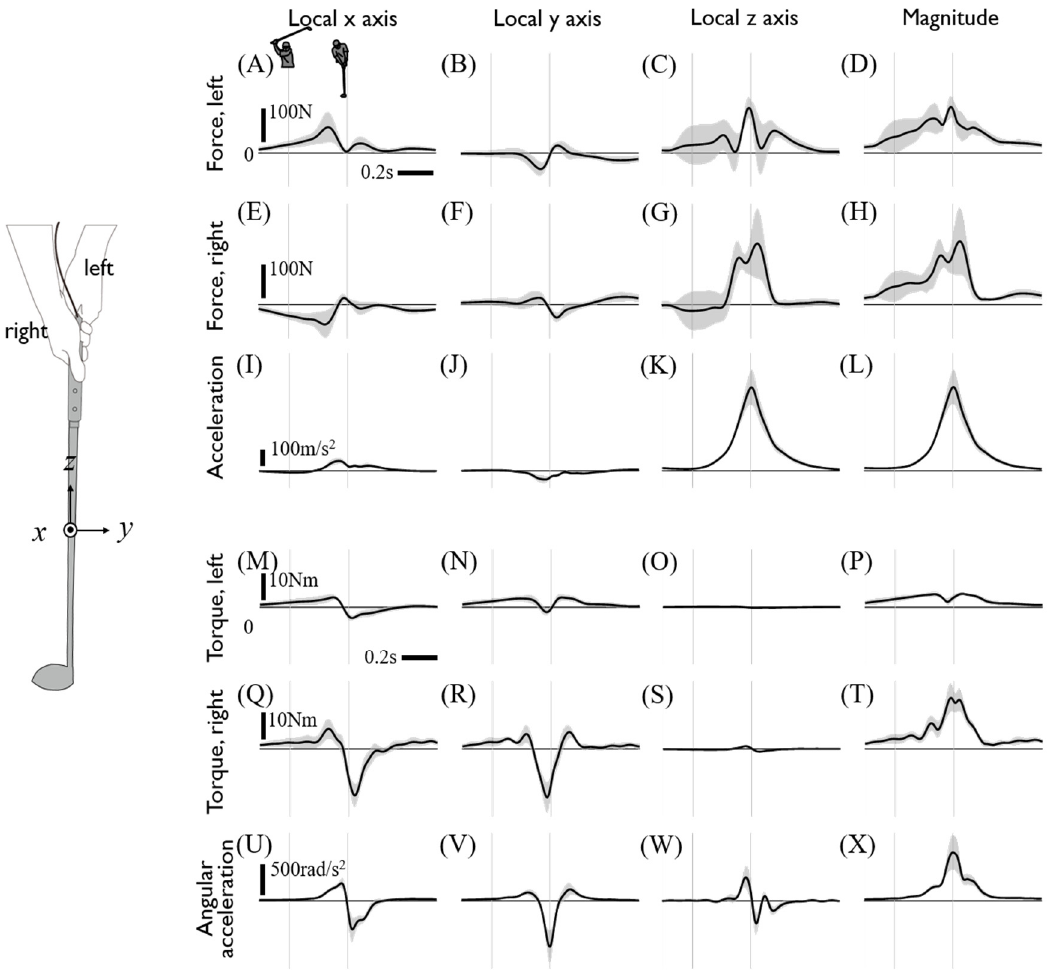
Figure 5. Hand-grip joint force and torque and kinematic data of the club. Each row shows the left ( A – D ) and right hand-grip joint force ( E – H ), acceleration of the club ( I – L ), left ( M – P ) and right hand-grip joint torque ( Q – T ), and the angular acceleration of the club ( U – X ), respectively. Each column shows the x, y, and z values and magnitude of each data at the club’s local coordinates. The force and torque act on the club, and all the data are the averages of driver swing data on all subjects. Two thin gray vertical lines indicate the backswing top and impact.